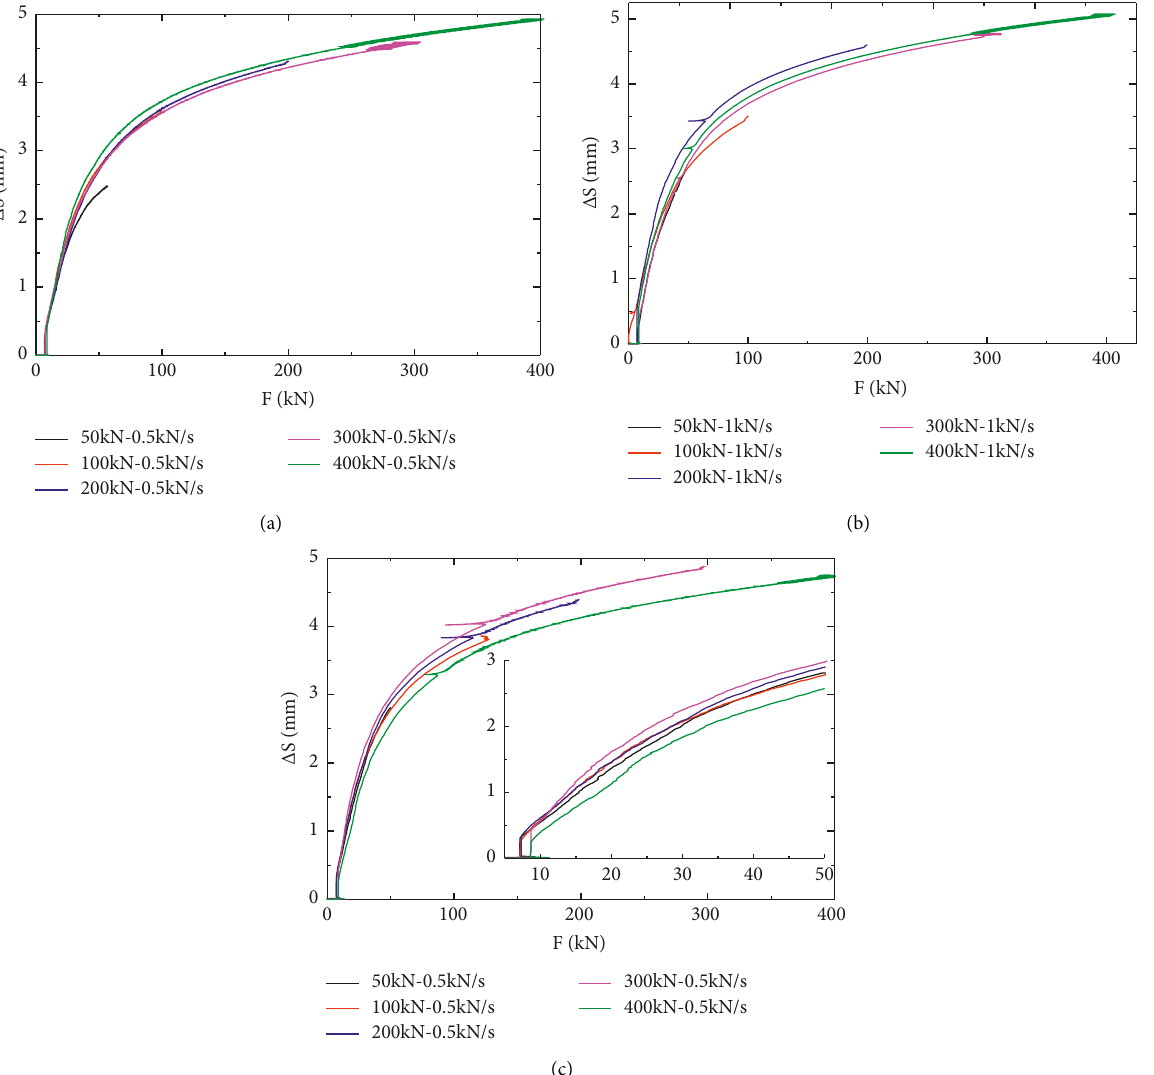
Figure 1: Variations of displacement with time and quasistatic load under loading speeds of 0.5–2.0kN/s. (a) Loading speed 0.5kN/s. (b) Loading speed 1.0kN/s. (c) Loading speed